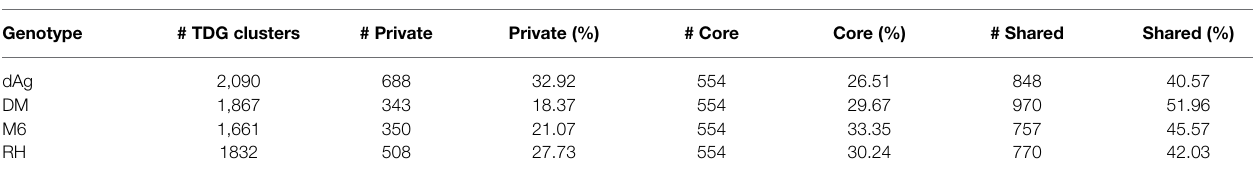
TABLE 3 | Number of TDG shared across potato